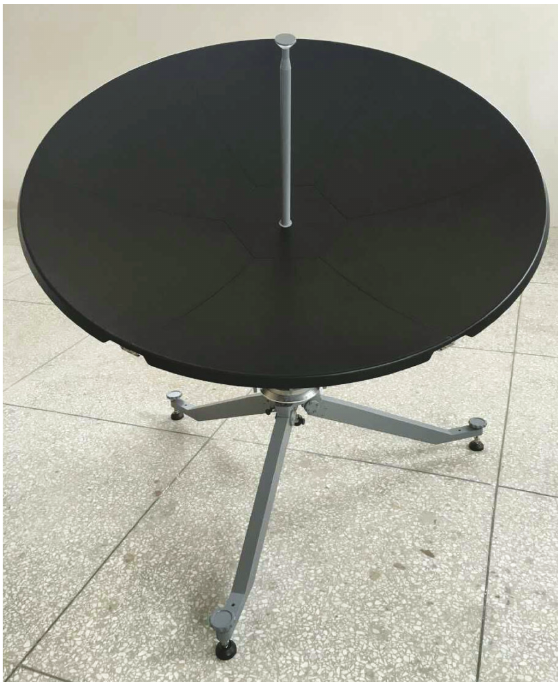
Figure 4: Antenna front